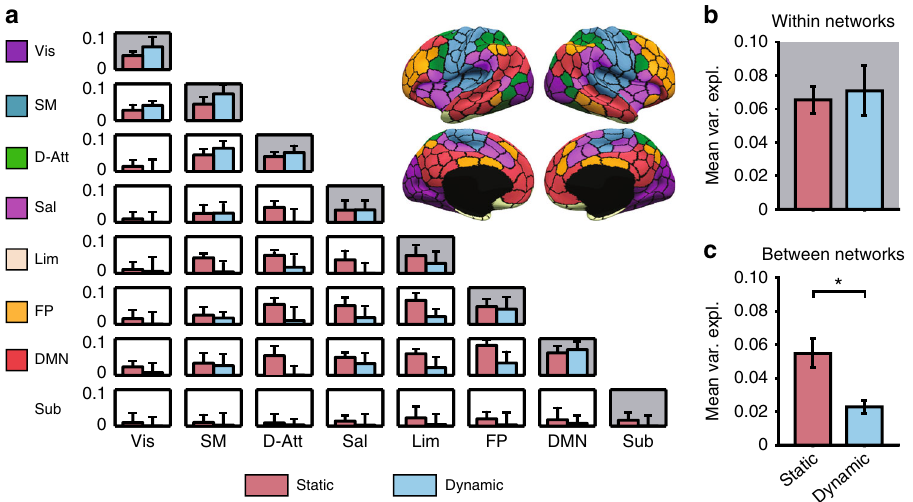
Fig. 3 Dynamic FC does not explain more behavioral variance than static FC within (pairs of) networks. a Behavioral variance explained by within-network (shaded diagrams) and between-network (unshaded diagrams), network static and dynamic FC. Seven cortical networks were used: visual (VIS), somatomotor (SM), dorsal attention (D-Att), salience (Sal), limbic (Lim), frontoparietal (FP), default mode network (DMN) and we also gathered the 19 subcortical areas (Sub). b There is no statistically signi fi cant difference in behavioral variance explained by within-network static and dynamic FC. c Between-network static FC explains more behavioral variance than between-network dynamic FC ( p = 8.31 × 10 − 3 ; two-tailed t -test). Error bars indicate SD of the